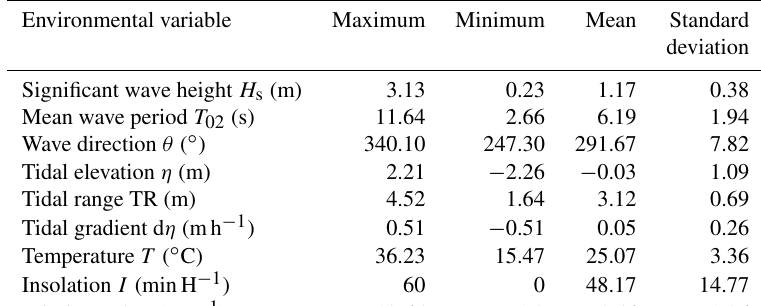
Table 3. Statistics of environmental conditions of SZI records during summers between 15 June–15 September.